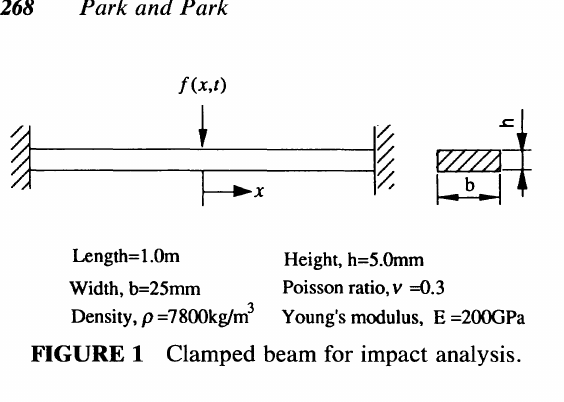
FIGURE 1 Clamped beam for impact